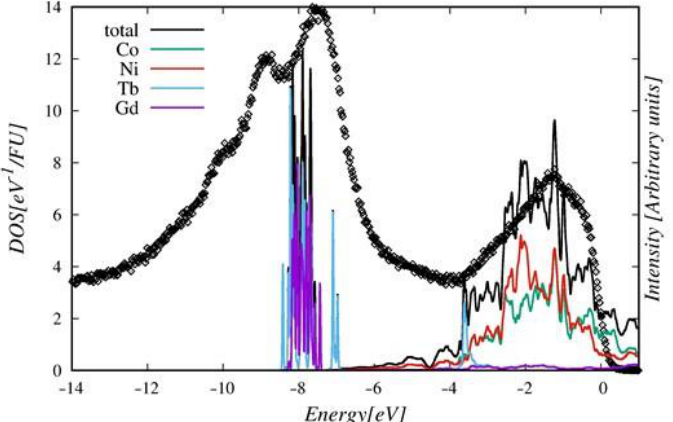
Figure 15. Atomic resolved and total DOS in Gd 0.4 Tb 0.6 (Co 0.5 Ni 0.5 ) 2 (solid lines), compared with the scaled XPS spectra (black points).